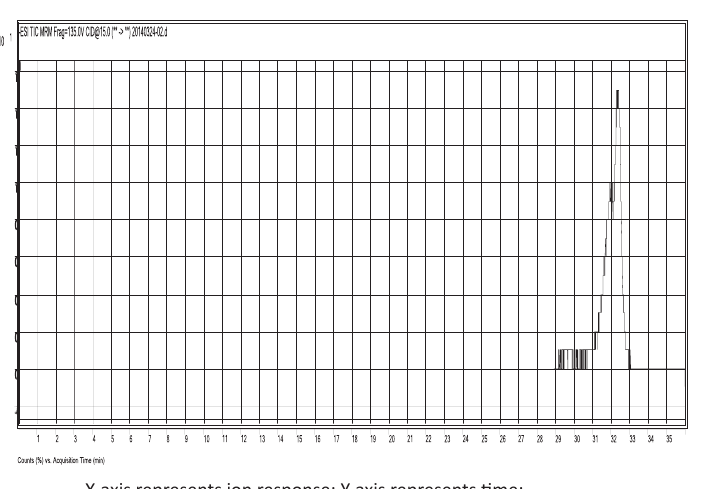
X-axis represents ion response; Y-axis represents time; Fig. 7. Chromatogram of citric acid with triple quadrupole